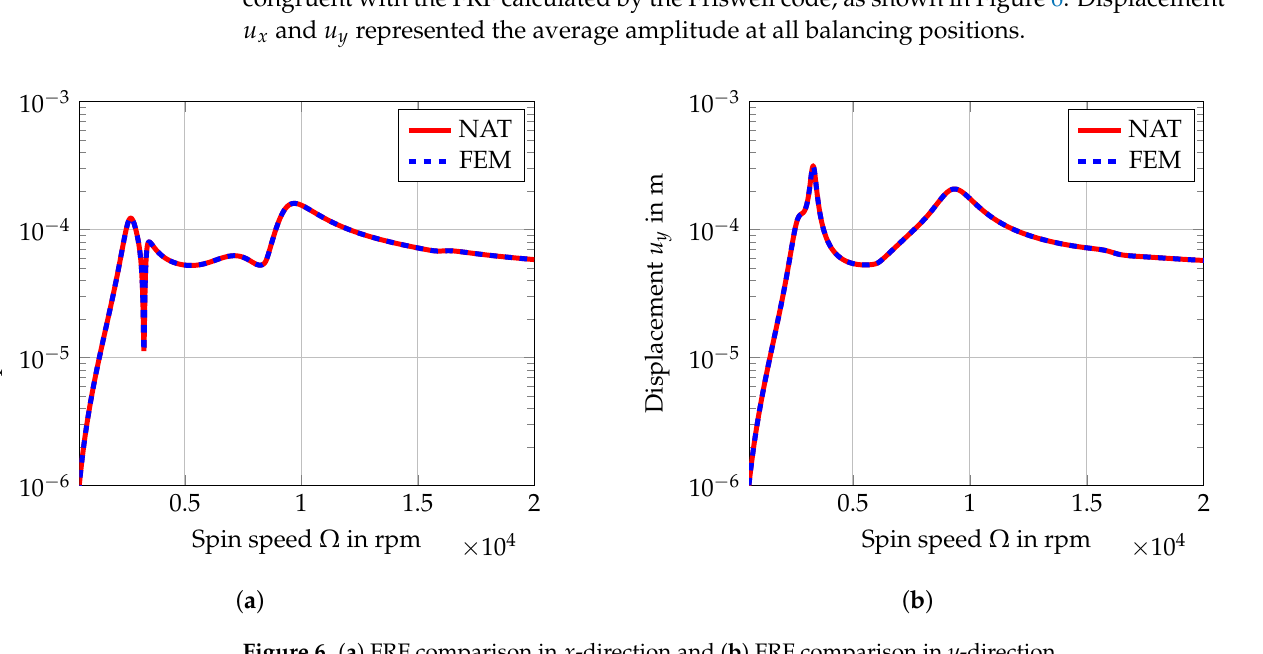
Figure 6. ( a ) FRF comparison in x -direction and ( b ) FRF comparison in y